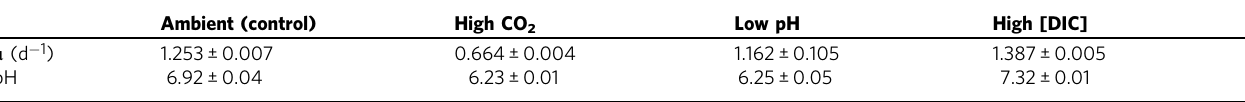
Table 1 Comparison of the speci fi c growth rate and concomitant pH of C. reinhardtii culture under high CO 2 -related stress application